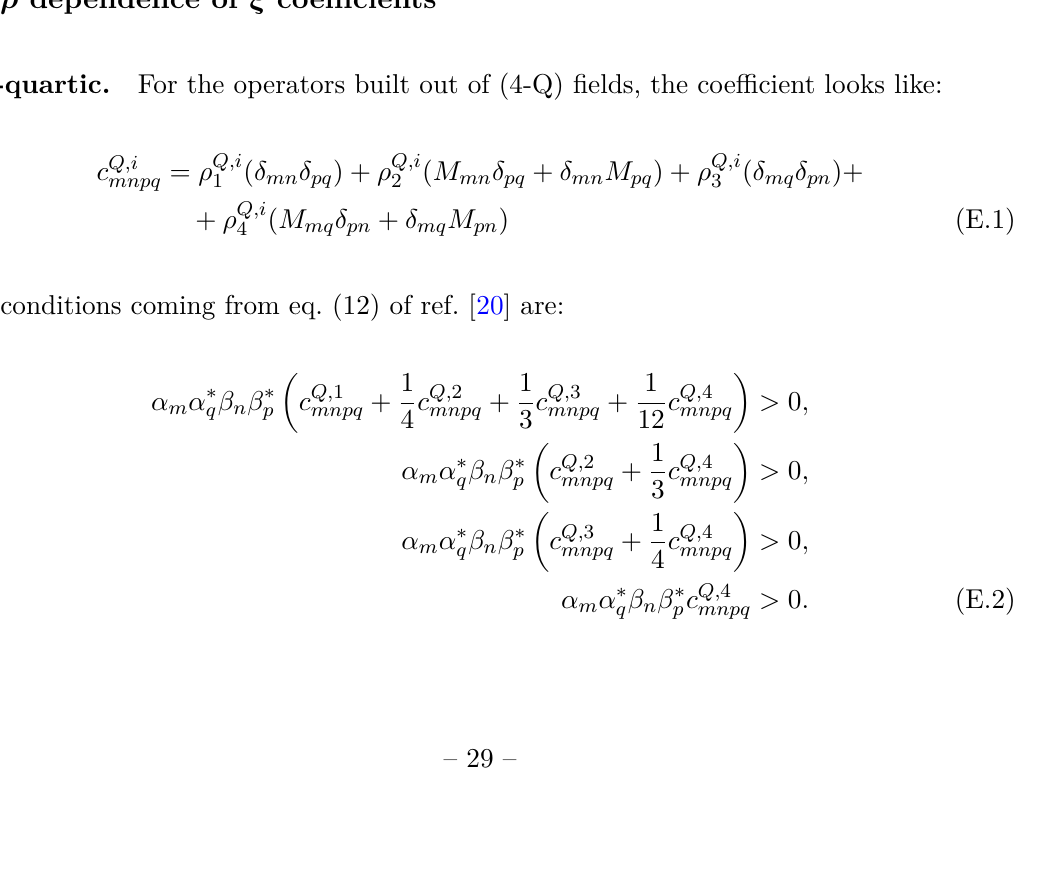
0 , so we 1 > is set to 1. The t = 1 , which can be seen being inside 1 , 2 , 3 , 4